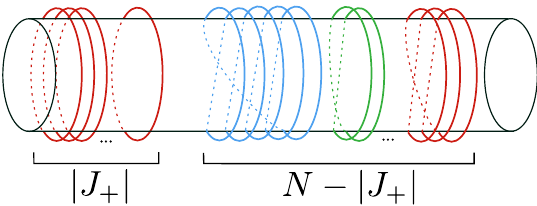
Figure 3 . A typical state with positive J + (cid:24) O ( N ) and J (cid:0) (cid:24) 0. The red strings carry ( J + ; J (cid:0) ) charges (1 ; 0) while the other strings carry other R-charges, including zero. The freedom to pick any colored partition of the remaining N (cid:0) j J + j elements gives rise to the entropy (3.13).